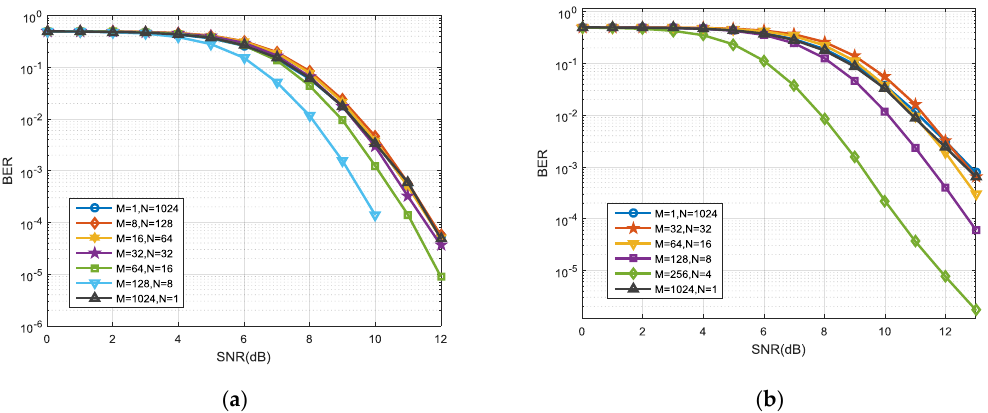
Figure 7. Performance comparison of UWAOSDM/PN system with different vector lengths: ( a ) system performance under channel model 1 ( b ) system performance under channel model 2.